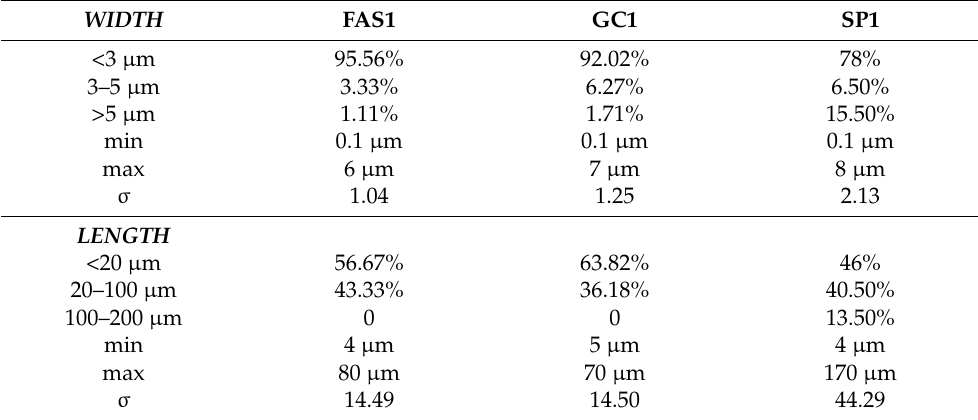
Table 1. Fiber size of investigated mordenites.